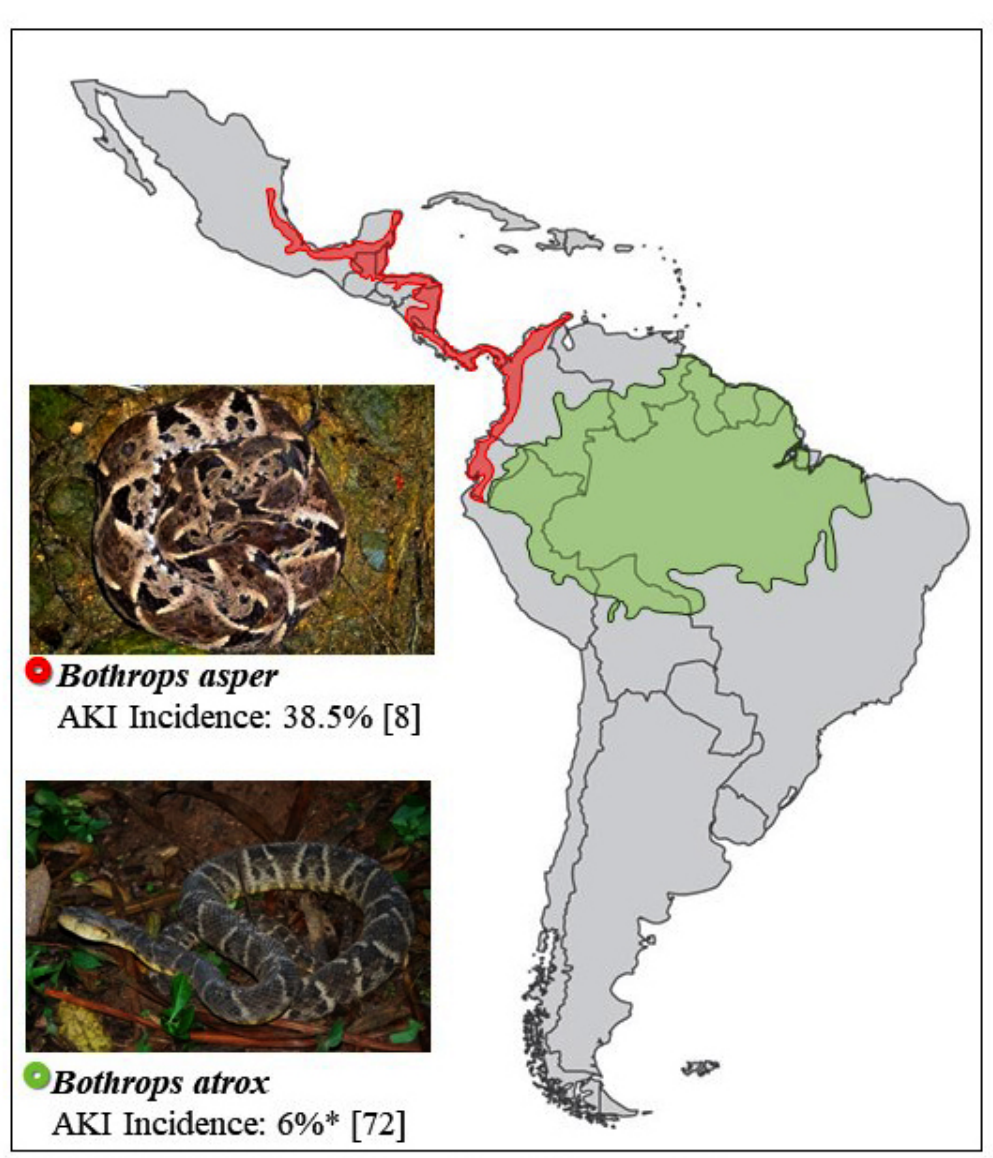
Figure 2. Geographical distribution of Bothrops asper (photo courtesy of Livia Correa, Special Laboratory of Zoological Collections, Butantan Institute, Brazil) and Bothrops atrox (photo courtesy of Marcelo Duarte, Laboratory of Zoological Collections, Butantan Institute, Brazil) and respective incidence of AKI in Latin